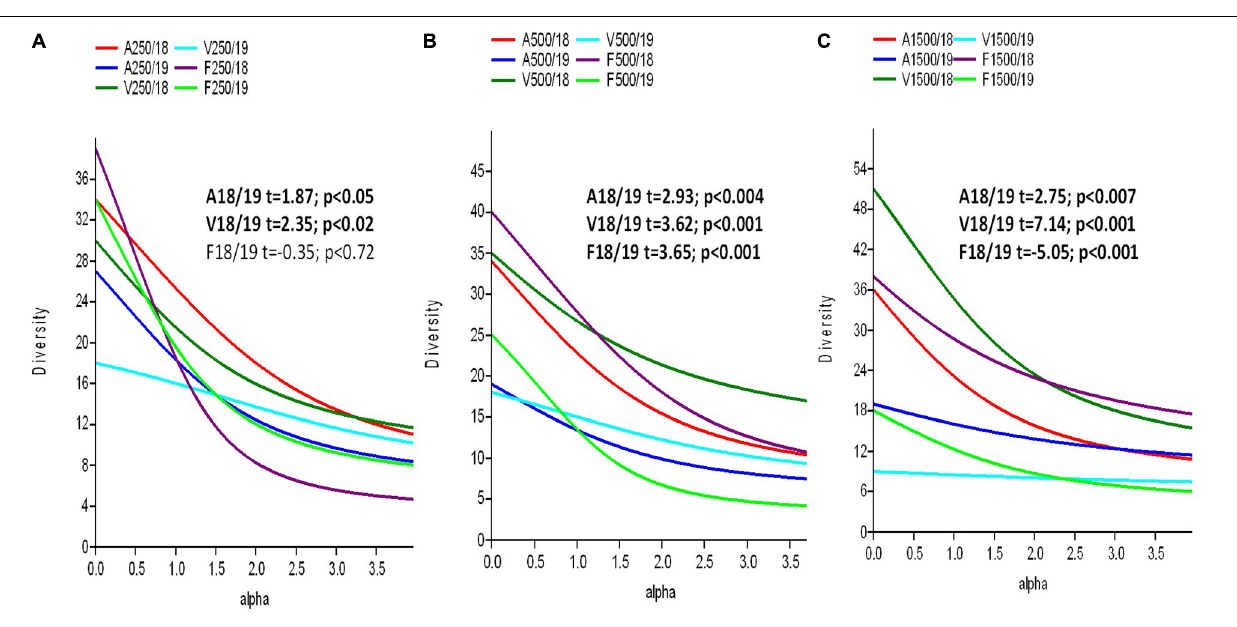
FIGURE 3 | The diversity profiles and diversity T -test of wild bees between years in the same site from 250 m (A) , 500 m (B) , and 1,500 m (C) from beehives. A confidence limit of P < 0.05 was considered. Methods reported by Tóthmérész (1995) were